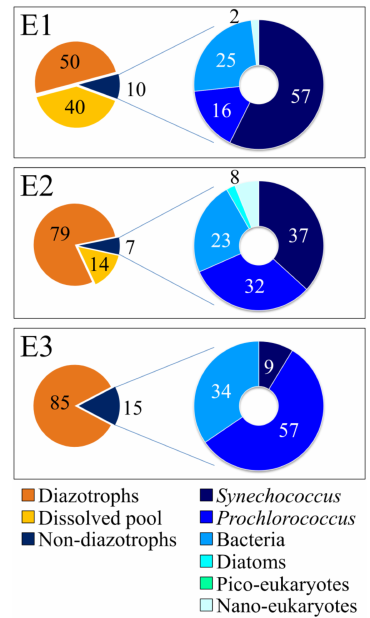
Figure 4. DDN fate after 48h for each experiment. Left pie charts: orange: DDN remained in diazotrophs (orange); yellow: DDN re- leased to the dissolved pool; dark blue: DDN transferred to non- diazotrophic plankton. Right pie charts, from dark blue to light blue: relative DDN transferred to Synechococcus , Prochlorococcus , bac- teria, diatoms, pico-eukaryotes and nano-eukaryotes in E1 (top), E2 (middle) and E3 (bottom pie